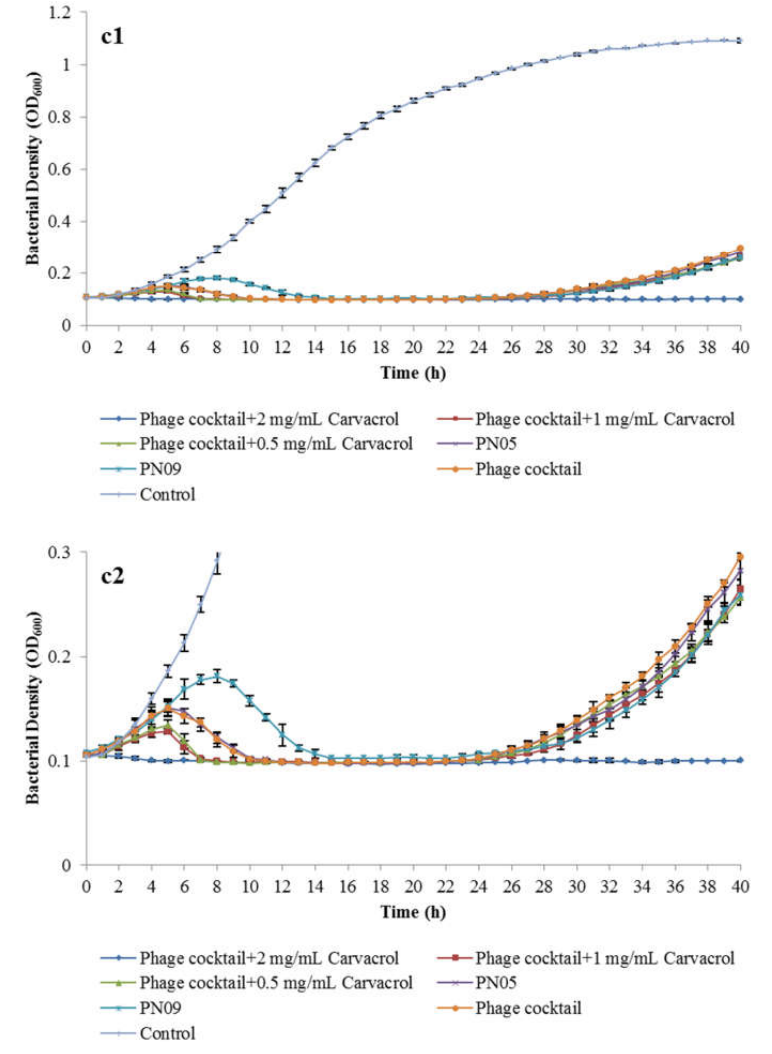
Figure 4. Psa (SCJY02-1) growth inhibition assay of phages (MOI = 1) and carvacrol. ( a ) PN05 and carvacrol, ( b ) PN09 and carvacrol ( c ), and phage cocktail and carvacrol ( c2 is an enlarged image of c1